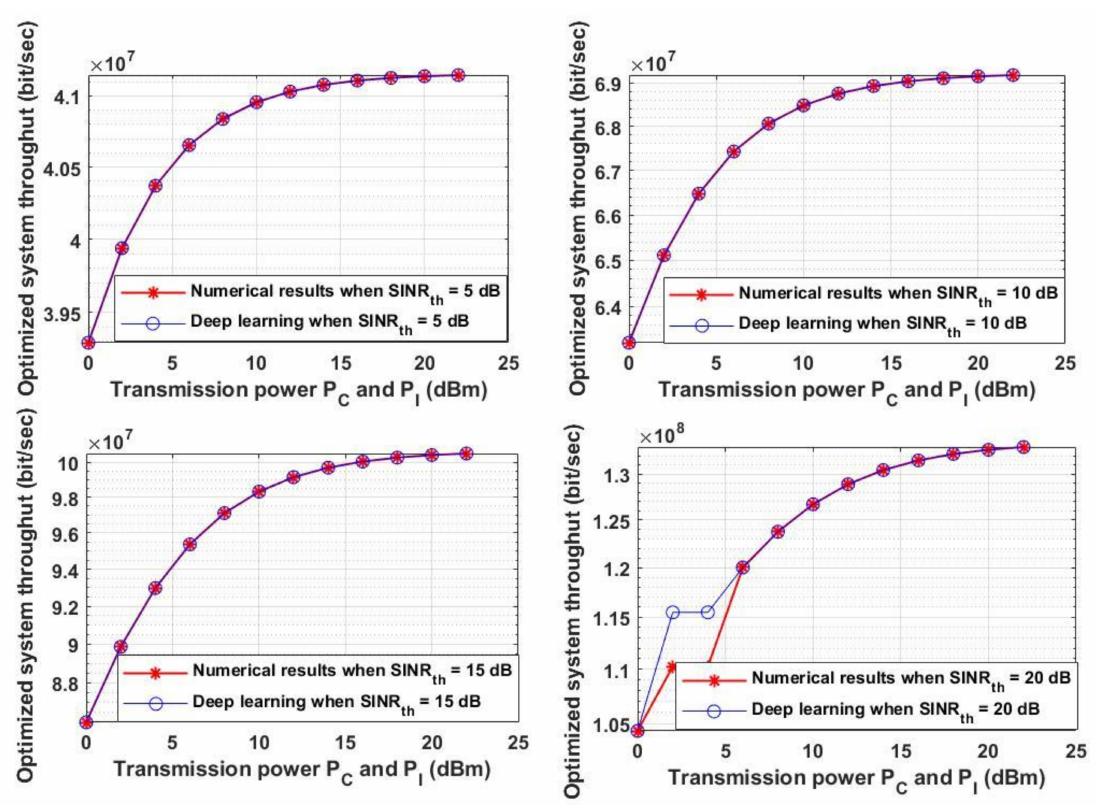
Figure 11. Transmission power P C and P I versus optimized system